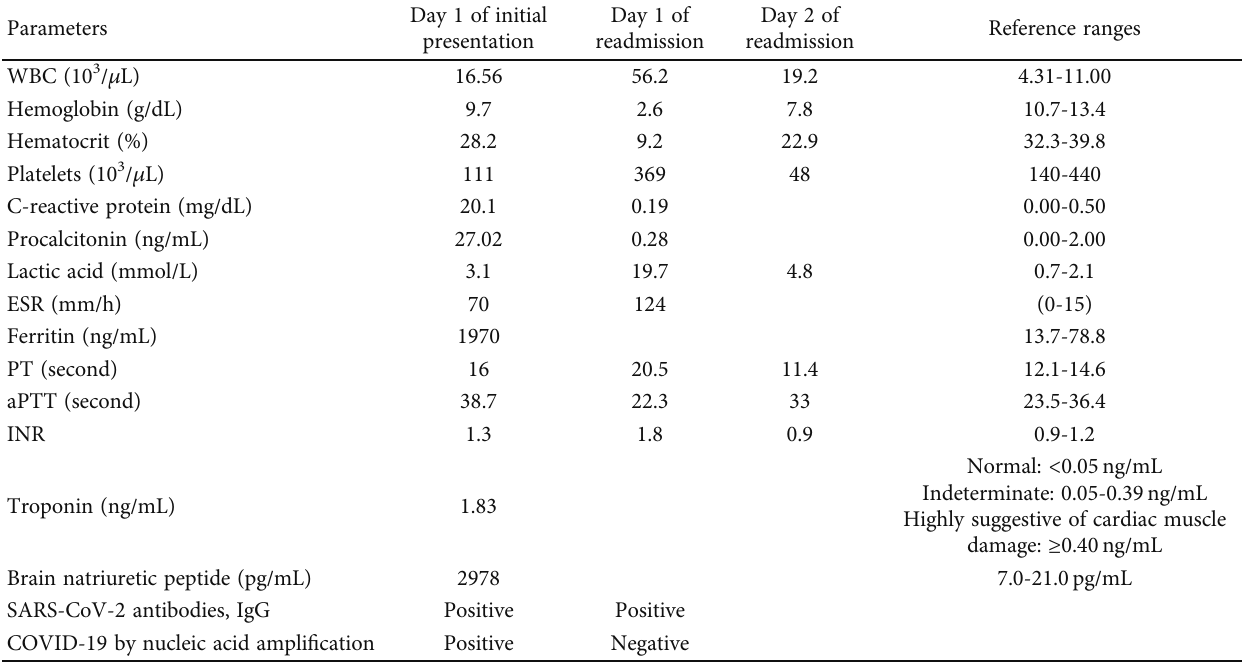
Table 1: Lab results for the patient are